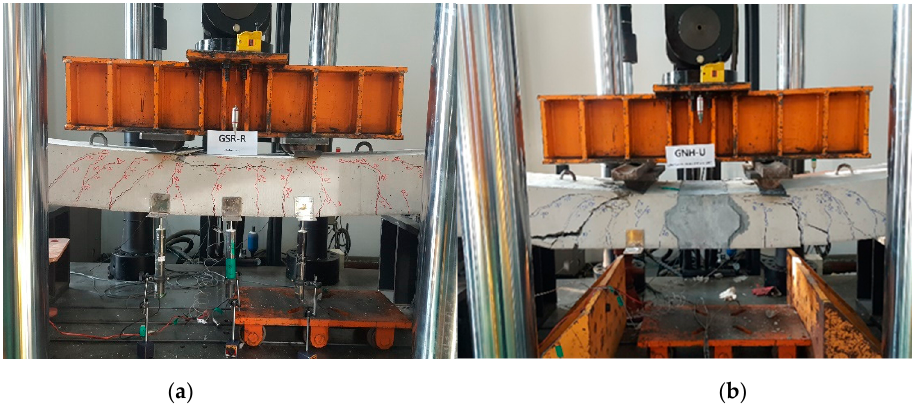
Figure 19. Flexural behavior of ( a ) GSR-R (Reference) and ( b ) GLC-UH.